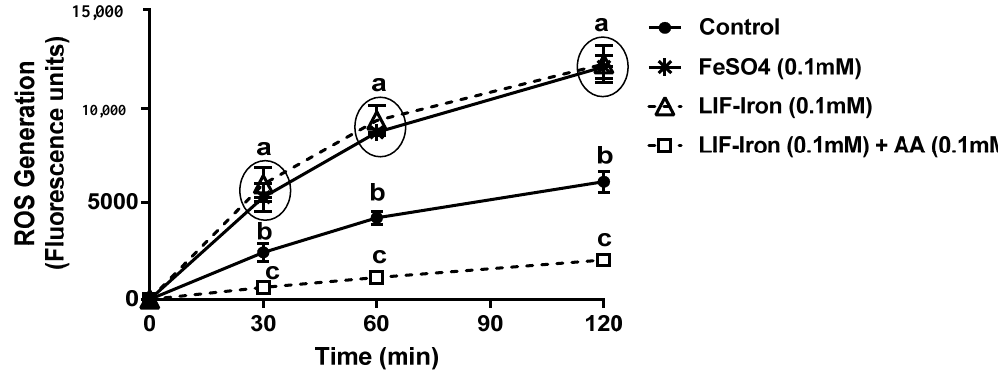
Figure 6. Effect of the iron ingot (Lucky Iron Fish™ (LIF)) on reactive oxygen species (ROS) generation. Cells were exposed to FeSO 4 (0.1 mM) or a similar LIF-iron concentration with or without AA. The intracellular ROS production was evaluated at 0, 30, 60 and 120 min. Data represent means ± SEM ( n = 8). Different letters indicate statistically significant differences at each time point ( p < 0.05).